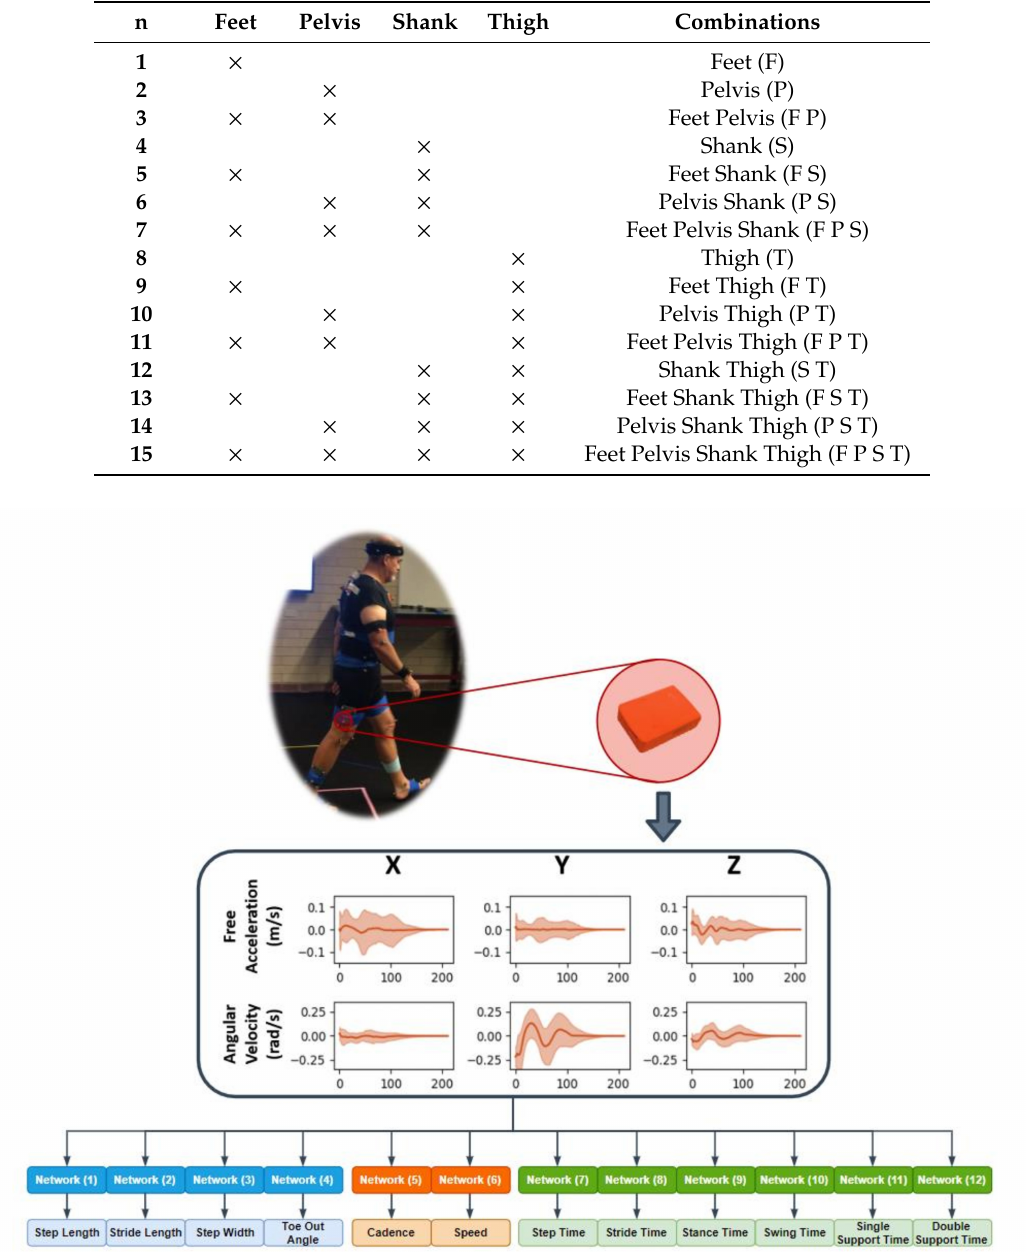
Table 2. Sensor combinations used in the design of experiment.